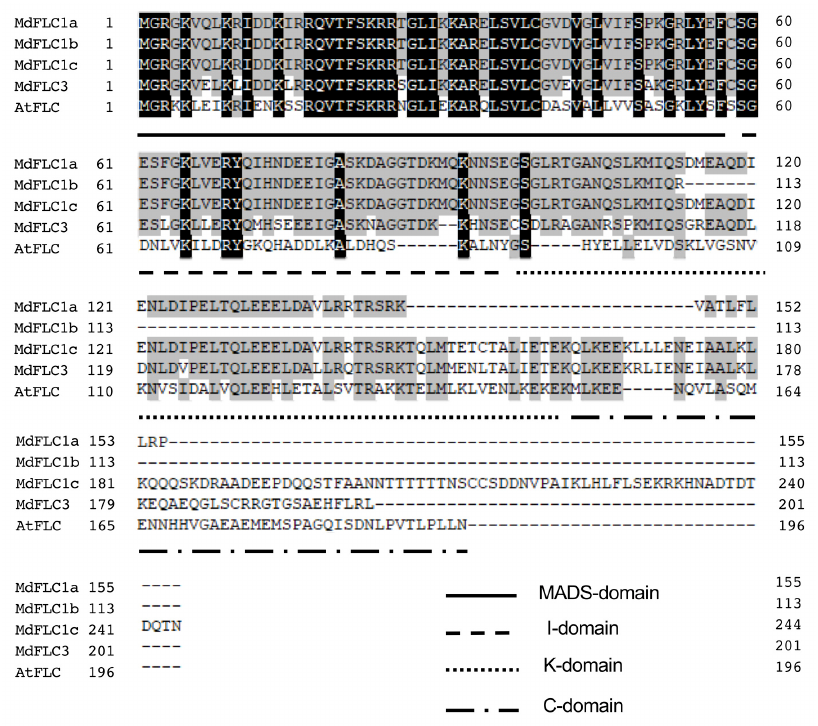
Figure 1. Amino acid sequence alignment of MdFLC and AtFLC. The MADS-, K-, I-, and C-domains are underlined. Identical amino acids for five and less proteins are shown in black and gray boxes,